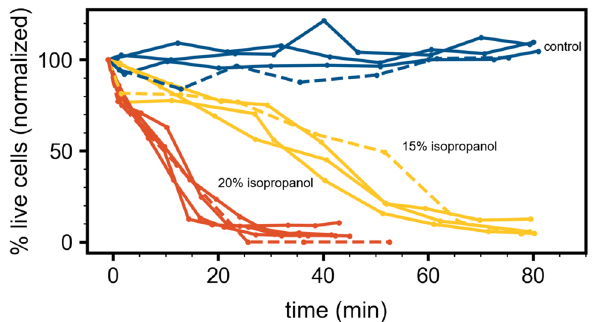
Figure 3. The horizontal axis represents time after the addition of alcohol. The vertical axis represented the percentage of live cells normalized by the initial time point before alcohol was added. All solid curves are measurements with THC and all dashed curves are staining measurements with trypan blue. The blue curves represent results from the control samples with no alcohol. The yellow curves represent results from samples with 15% isopropanol by volume. The orange curves represent results from the samples with 20% isopropanol by